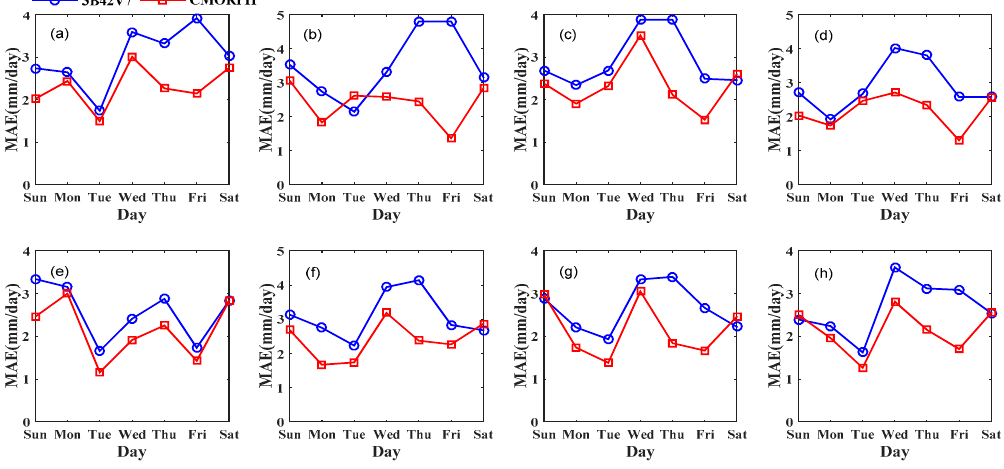
Figure 4. The variations of MAEs from 3B42V7 and CMORPH at the daily scale from Sunday to Saturday (( a – h ) indicate that the gauge ID in Table 1).